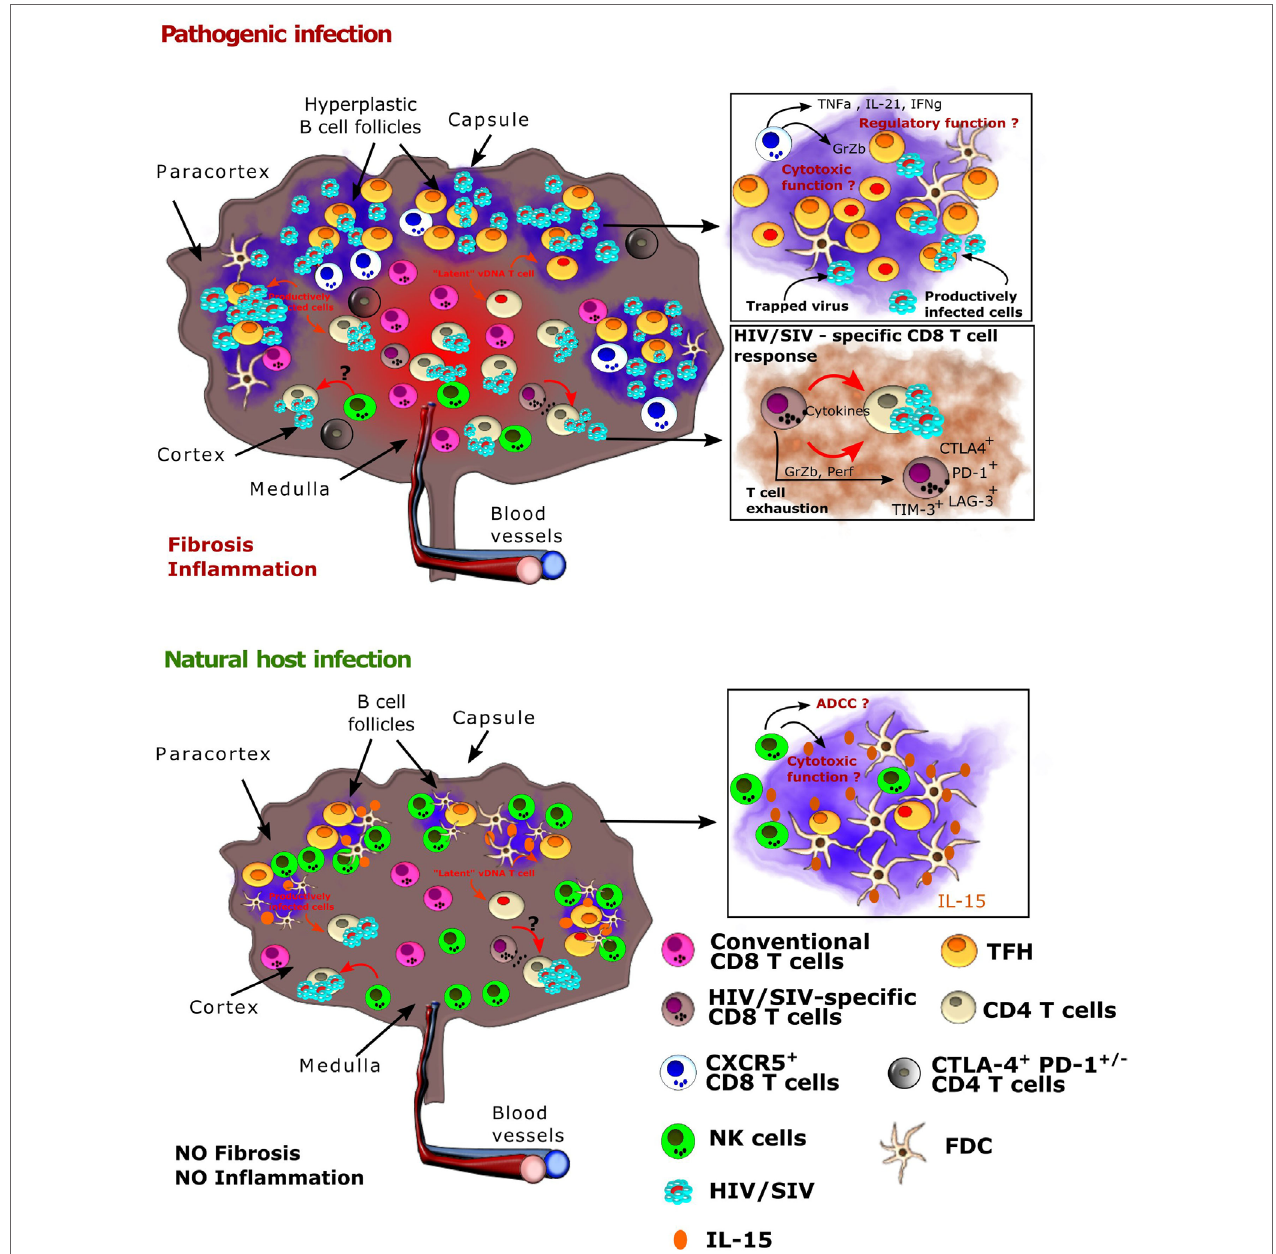
FiGURe 1 | Viral and host immune cell dynamics in lymph nodes (LNs) from natural hosts versus HIV-1/SIVmac infections. Schematic representation of a LN after HIV or SIV infection in pathogenic models (human, macaques, top) and natural hosts [African green monkey (AGM), sooty mangabey, bottom]. ( Top ) HIV-1 and SIVmac infection in, respectively, humans and macaques result in the formation of hyperplastic germinal centers in LNs with massive B cell proliferation. T FH cells also expand during HIV-1 and SIVmac infections. Inflammation is uncontrolled and leads to collagen deposition and fibrosis. The follicular dendritic cell (FDC) network is disrupted on the long term. HIV-1 and SIVmac replicates in combined antiretroviral therapy (cART)-naïve individuals and animals in both T and B cell zones, but the viral burden is highest in the B cell zones (follicles). In the follicles, virus replication is concentrated within follicular helper T cells (T FH ). Virus is also trapped by FDC and remains infectious. On cART, virus persists mostly in T FH cells in the follicles, where it is often outreach of conventional CD8 + T cells and of optimal drug concentrations, as well as in CTLA4 + CD4 + T cells within the T zone. The latter cells have a capacity for long survival. NK cells and conventional HIV/ SIV-specific CD8 + T cells are often expressing immune checkpoint inhibitors. The presence of CXRC5 + CD8 + T lymphocytes has been described, but their role needs to be further studied. ( Bottom ) In natural hosts, virus replication is strongly controlled during the chronic phase of infection. Most follicles are exempt of virus. Conventional SIV-specific CD8 + T cell responses are weak. NK cells play a major role in the control of viral replication in AGM LNs. Both the IFN- α and NK cell responses appear earlier than in SIVmac-infected macaques. NK cells accumulate in follicles in SIVagm-infected AGMs, which might be a direct consequence of a high production of IL-15 in the follicles. NK cell migration into B cell follicles in response to SIVagm infection is associated with the acquisition of CXCR5. CXCR5 + NK cells express high levels of Fc γ receptors and of CD107a, which raises the question if they have the capacity to control SIVagm replication through antibody - dependent and/or -independent cellular cytotoxicity.